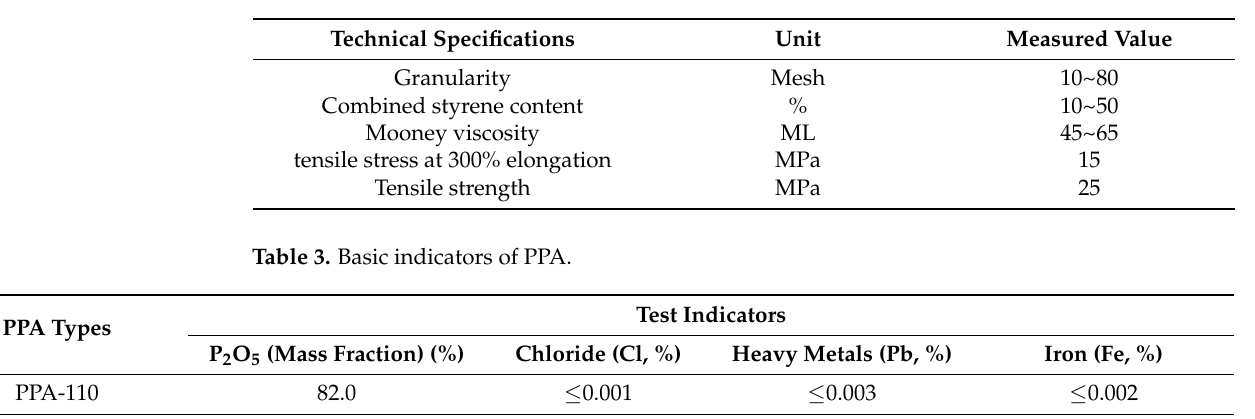
Table 2. Main technical specifications of SBR.